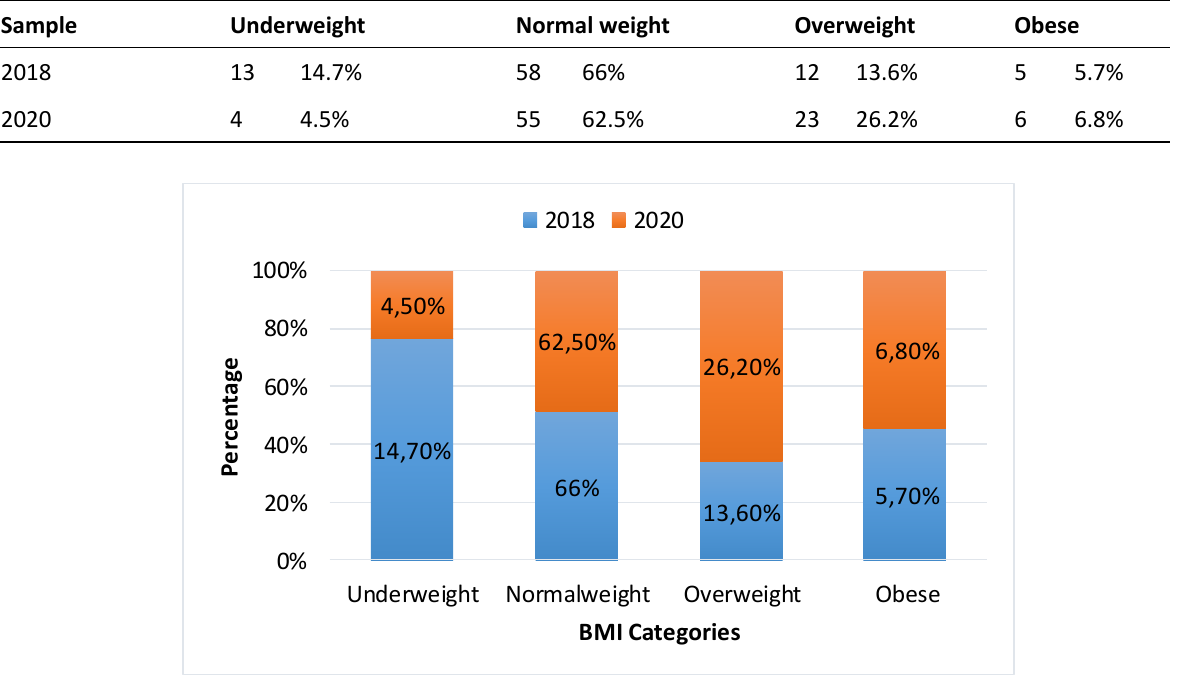
Fig 1. Percentage